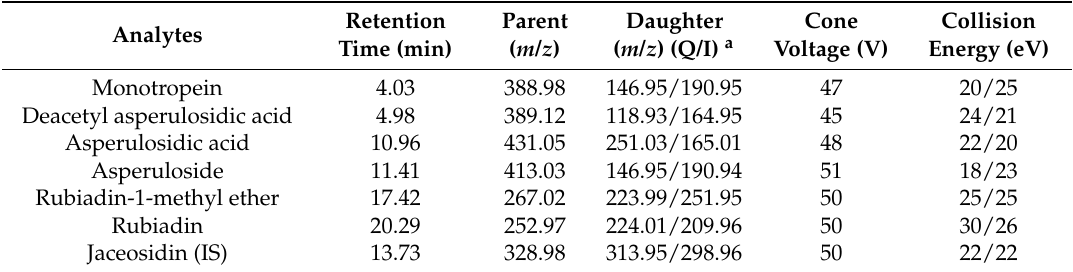
Table 1. MS parameters of the target analytes and jaceosidin.